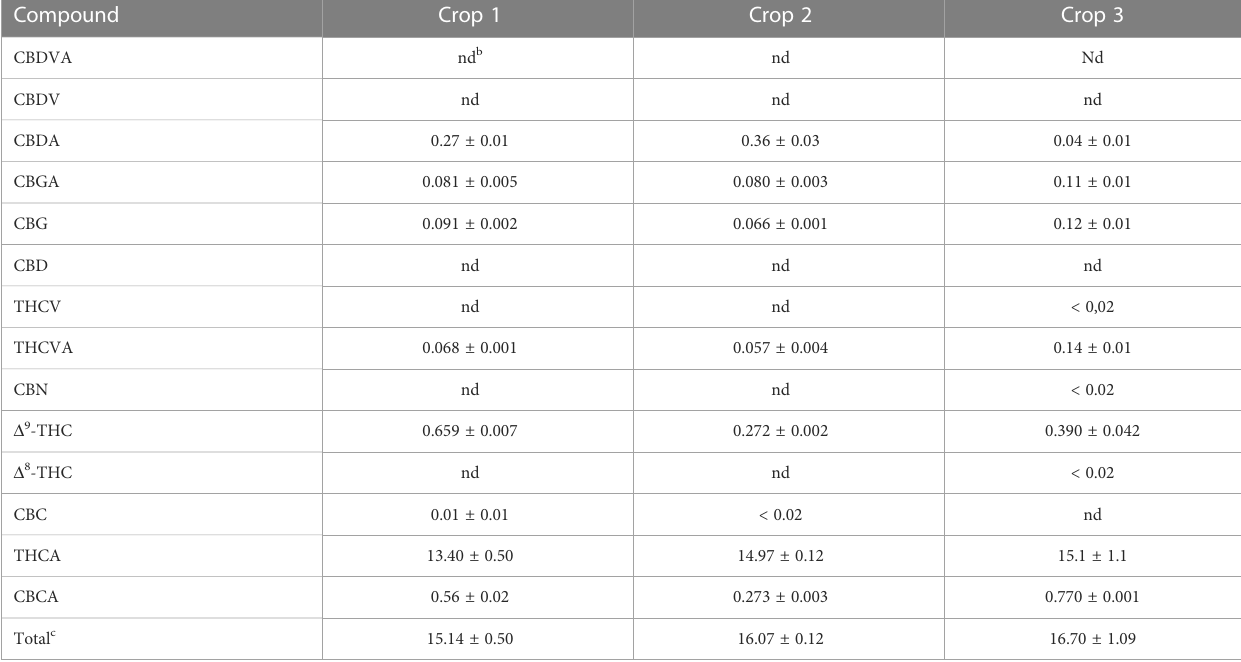
TABLE 1 Composition of chemovar A plant material (mean ± SD) a